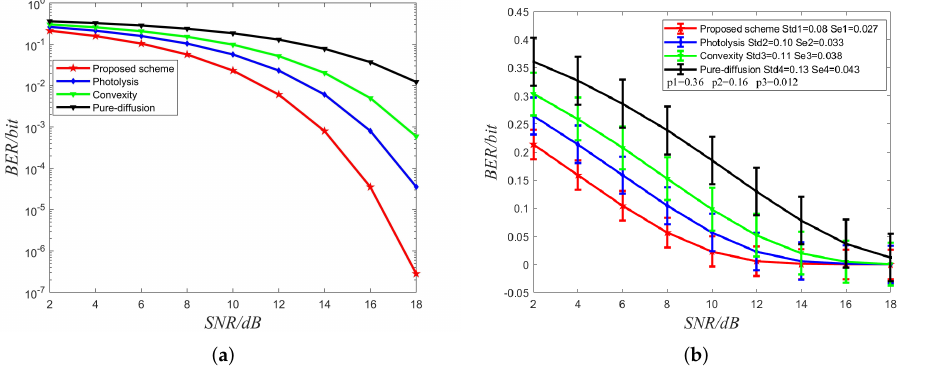
Figure 6. ( a ) Bit Error Ratio (BER) performance comparison of the proposed method with the methods in the previous reference. dB denotes the unit of signal-to-noise ratio (SNR). ( b ) Std and Se denote standard deviations and standard error, respectively. p1, p2 and p3 denote the p -values of the comparison between the proposed method with photolysis, convexity and pure diffusion,